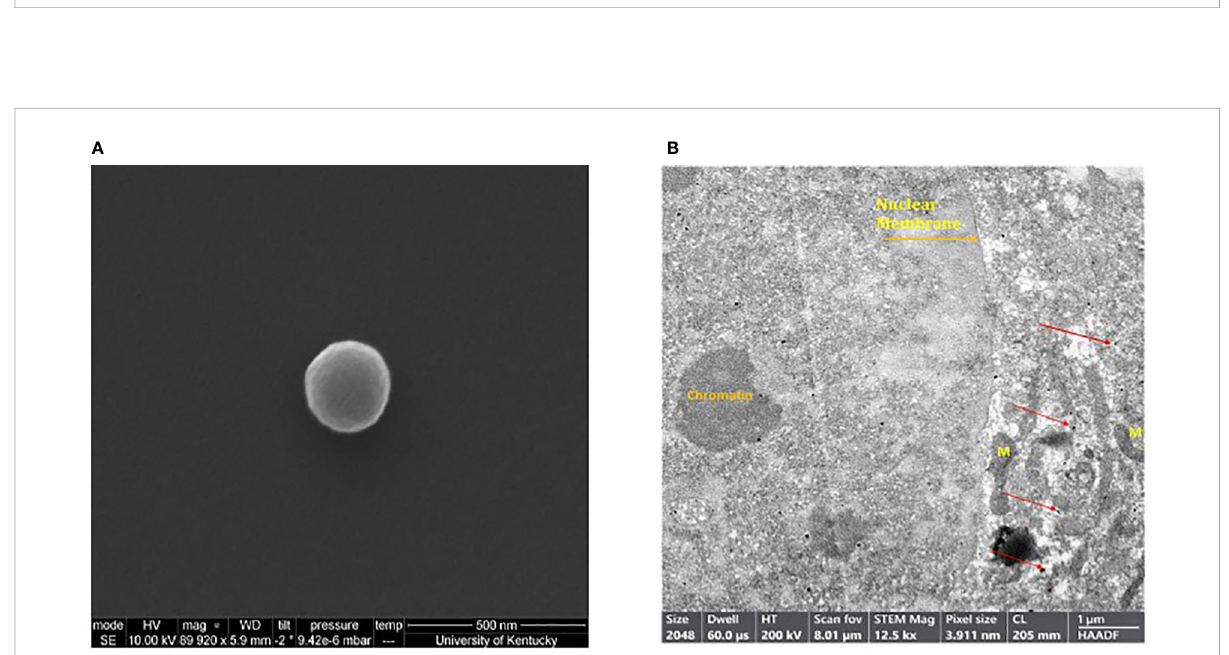
FIGURE 2 (A) Scanning electron microscope image of a single human M1 MEV. Sample was imaged using a fi eld-emission scanning electron microscope. (B) Transmission electron microscopy of SKOV3 ovarian cell with intracellular MEVs as identi fi ed with positive silver staining for CD86. MEVs (black dots) are identi fi ed within the cell (red arrows). The nuclear membrane, chromatin, and Mitochondria (M) are also